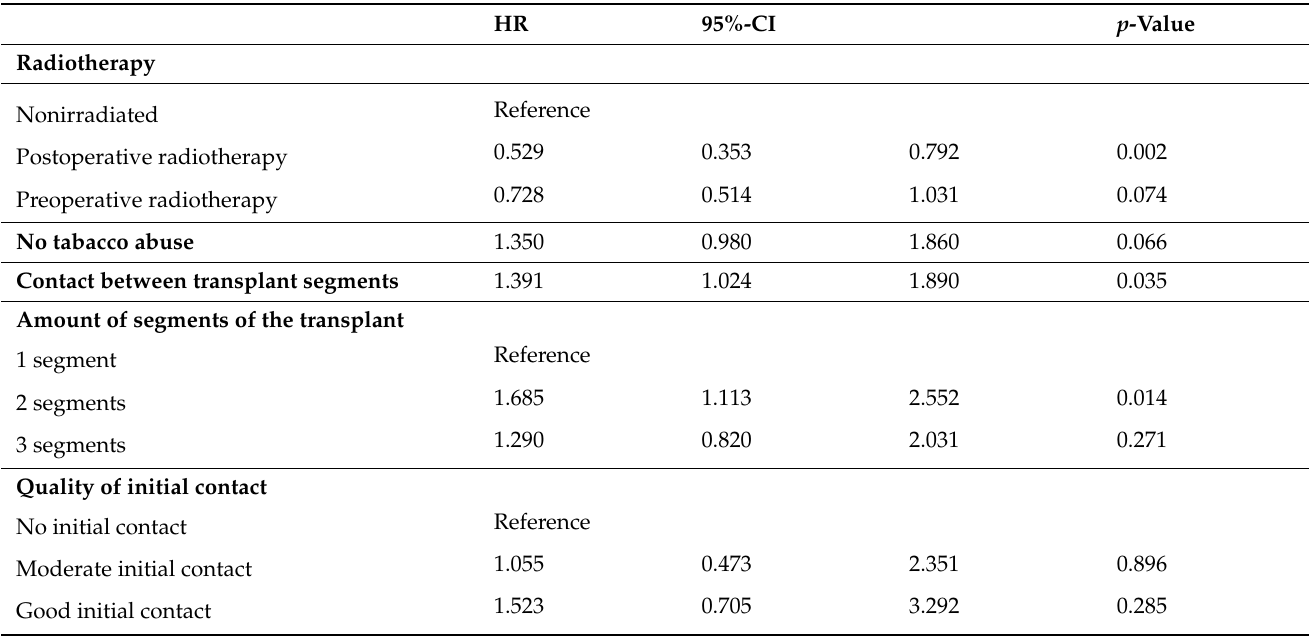
Table 3. Multivariable Cox regression model on ossification. HR 95%-CI p